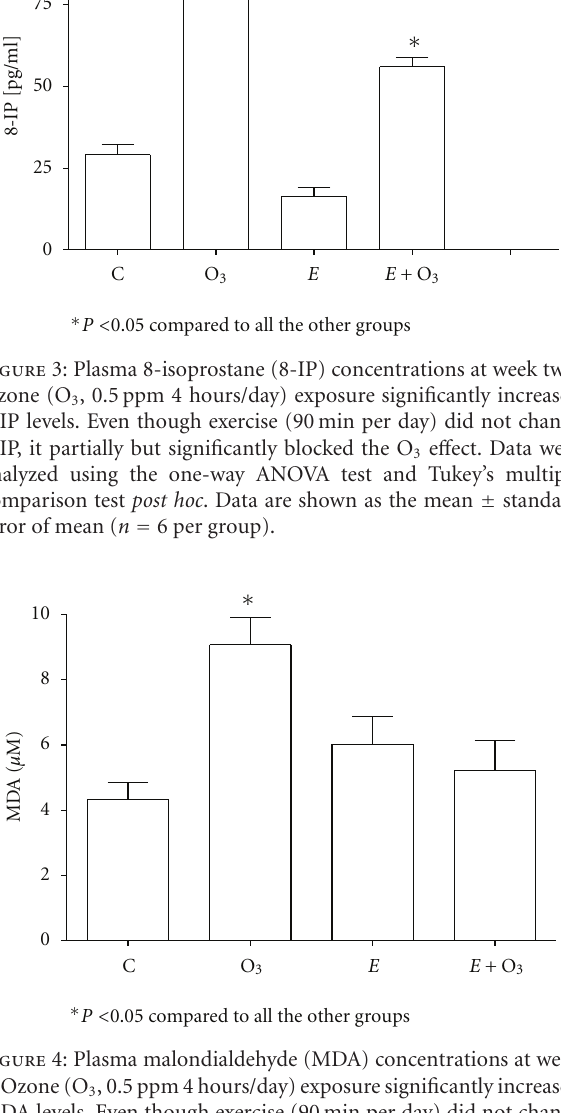
Figure 2: Plasma NO x concentrations at week two. Ozone (O 3 ) exposure (0.5 ppm 4 hours/day) significantly decreased whereas exercise ( E , 90min per day) significantly increased plasma NO x concentrations. The e ff ect of O 3 exposure was completely blocked by exercise. Data were analyzed using the one-way ANOVA test and Tukey’s multiple comparison test post hoc . Data are shown as the mean ± standard error of mean ( n = 6 per group).